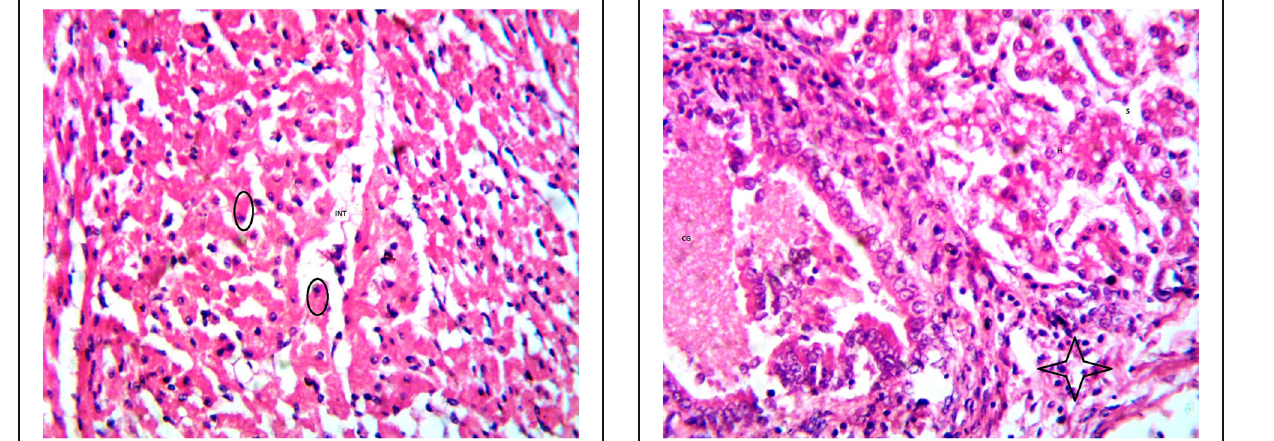
Fig. 3 Heart section of broiler chicken fed 8.0% of PCHM-inclusive diet showing the myocardium composed of the cardiac muscle with peripherally placed nucleus (circle) separated by a defined interstitium (INT) that is free of inflammatory cells and